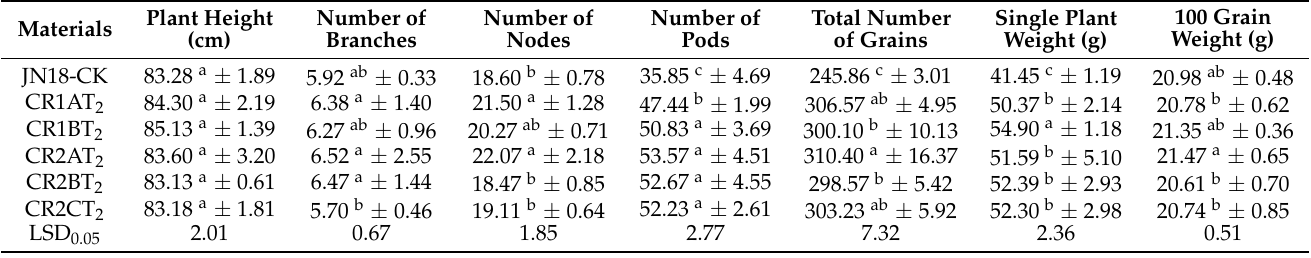
Table 4. Determination of agronomic traits of different editing vectors in T 2 plants.